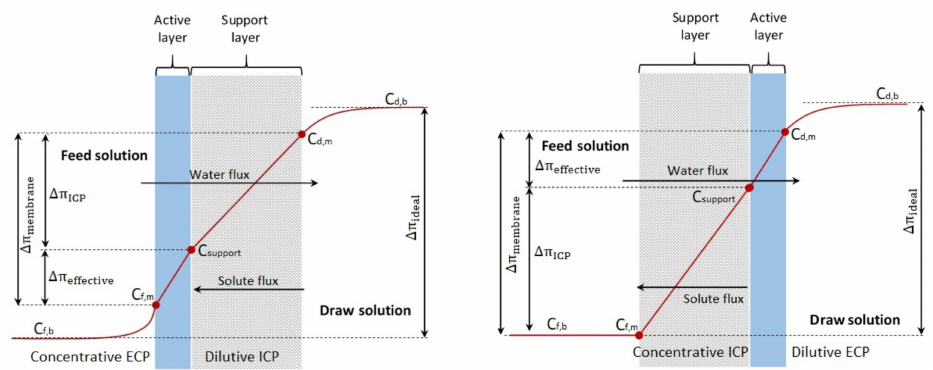
Figure 12. Schematic descriptions of ECP and ICP at AL–FS orientation (left-hand side figure) and AL–DS orientation (right-hand side